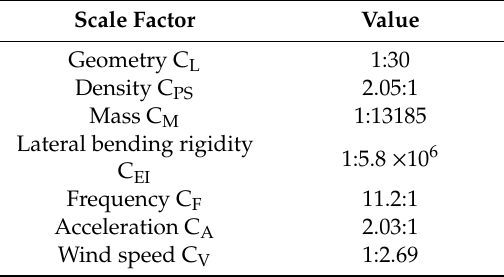
Table 4. Scale factors of aeroelastic tower